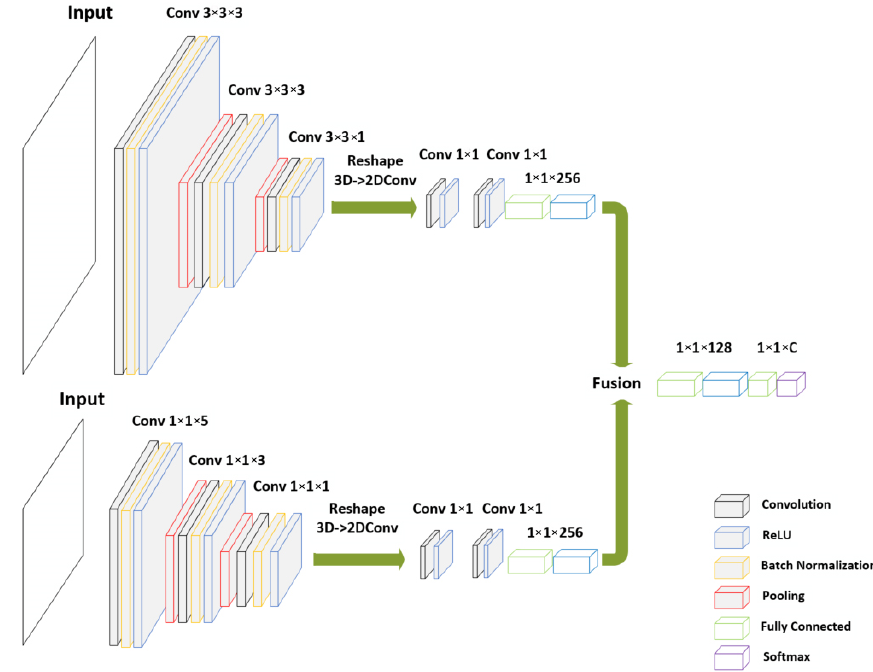
Figure 6. DSEN (The upper channel is a spatial–spectral extraction channel and the lower channel is a spectral extraction channel).